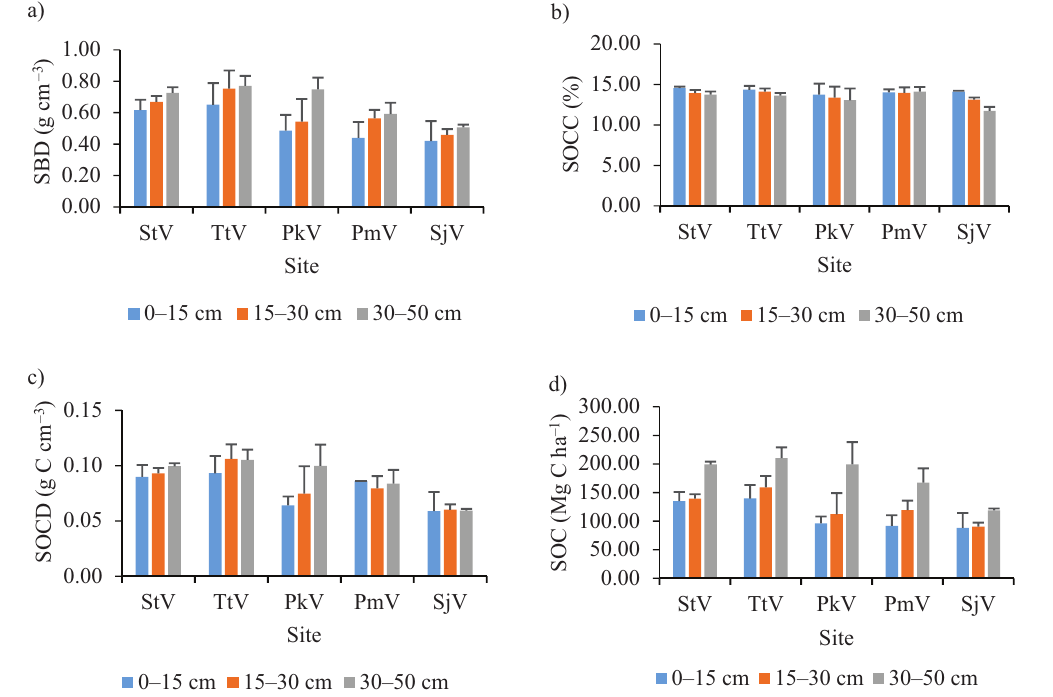
Figure 2. Soil properties: a) SBD, b) SOCC, c) SOCD, and d) SOC in the mangrove forests of Sinjai District, South